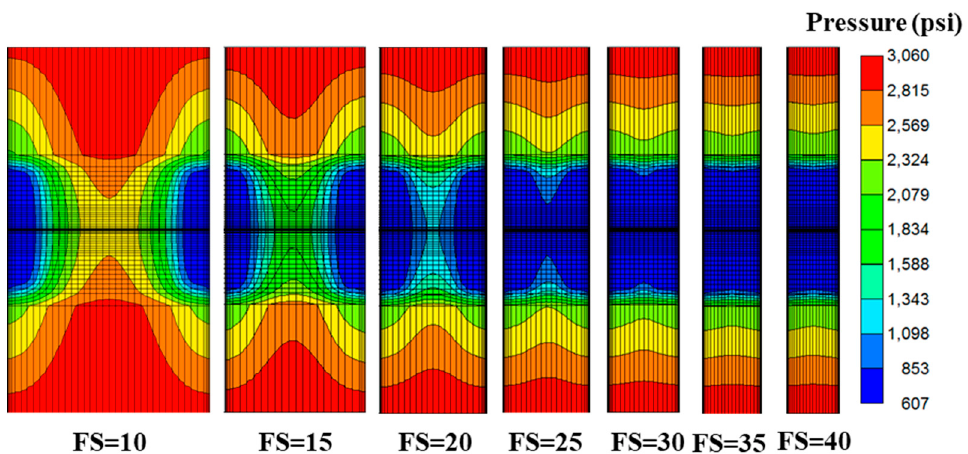
Figure 8. IFT during natural depletion (ND) and CGI by CO 2 , C 2 H 6 and NG, Oil API=31°. 2.3. Effect of gas type coupled with fracture spacing This section is focused on identifying an optimum fracture spacing for each scenario that gives the higher oil production regardless of any other factor. The contour plots of average reservoir pressure after one year of natural depletion between two adjacent fracture stages are shown in Figure 9. The figure shows that quick pressure depletion occurs mostly within the SRV region ( K m =0.008 md and K f =0.02 md ) due to conductive fracture network, while pressure in USRV region ( K m =0.0005 md and K f =0.001 md ) remains almost the same as the initial reservoir pressure. This behavior also demonstrates the importance of fracking stimulation operations in unconventional reservoirs. Yet, a large area of the reservoir will remain un-depleted, hence the production ends with a high residual oil saturation. The figure also demonstrates the effect of fracture spacing on reservoir pressure distribution. More number of stages decreases fracture spacing, leading to more uniform pressure depletion. However, in the lowest fracture stage, the area between neighbor fractures will not deplete effectively. Table 2 compares the ultimate recovery factors from various scenarios with the largest fracture spacings (fracture stages=10, 15 and 20). Recovery factors from each scenario are obtained and the results are shown in Figure 10 to Figure 21 for both high and low oil API gravities. Comparing the ultimate recovery of oil, extended cycles in wide fracture spacings leads to more effective extraction of